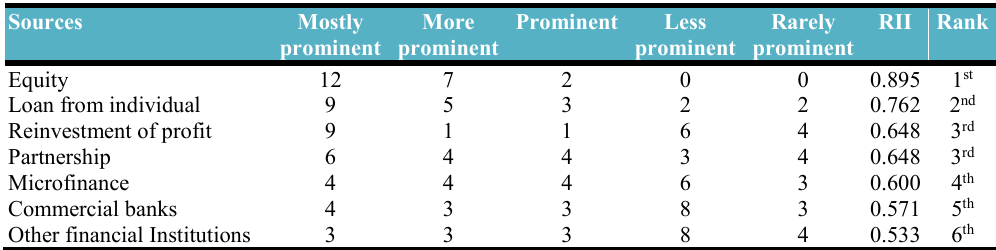
Table 5. Sources of Financing Land Speculation